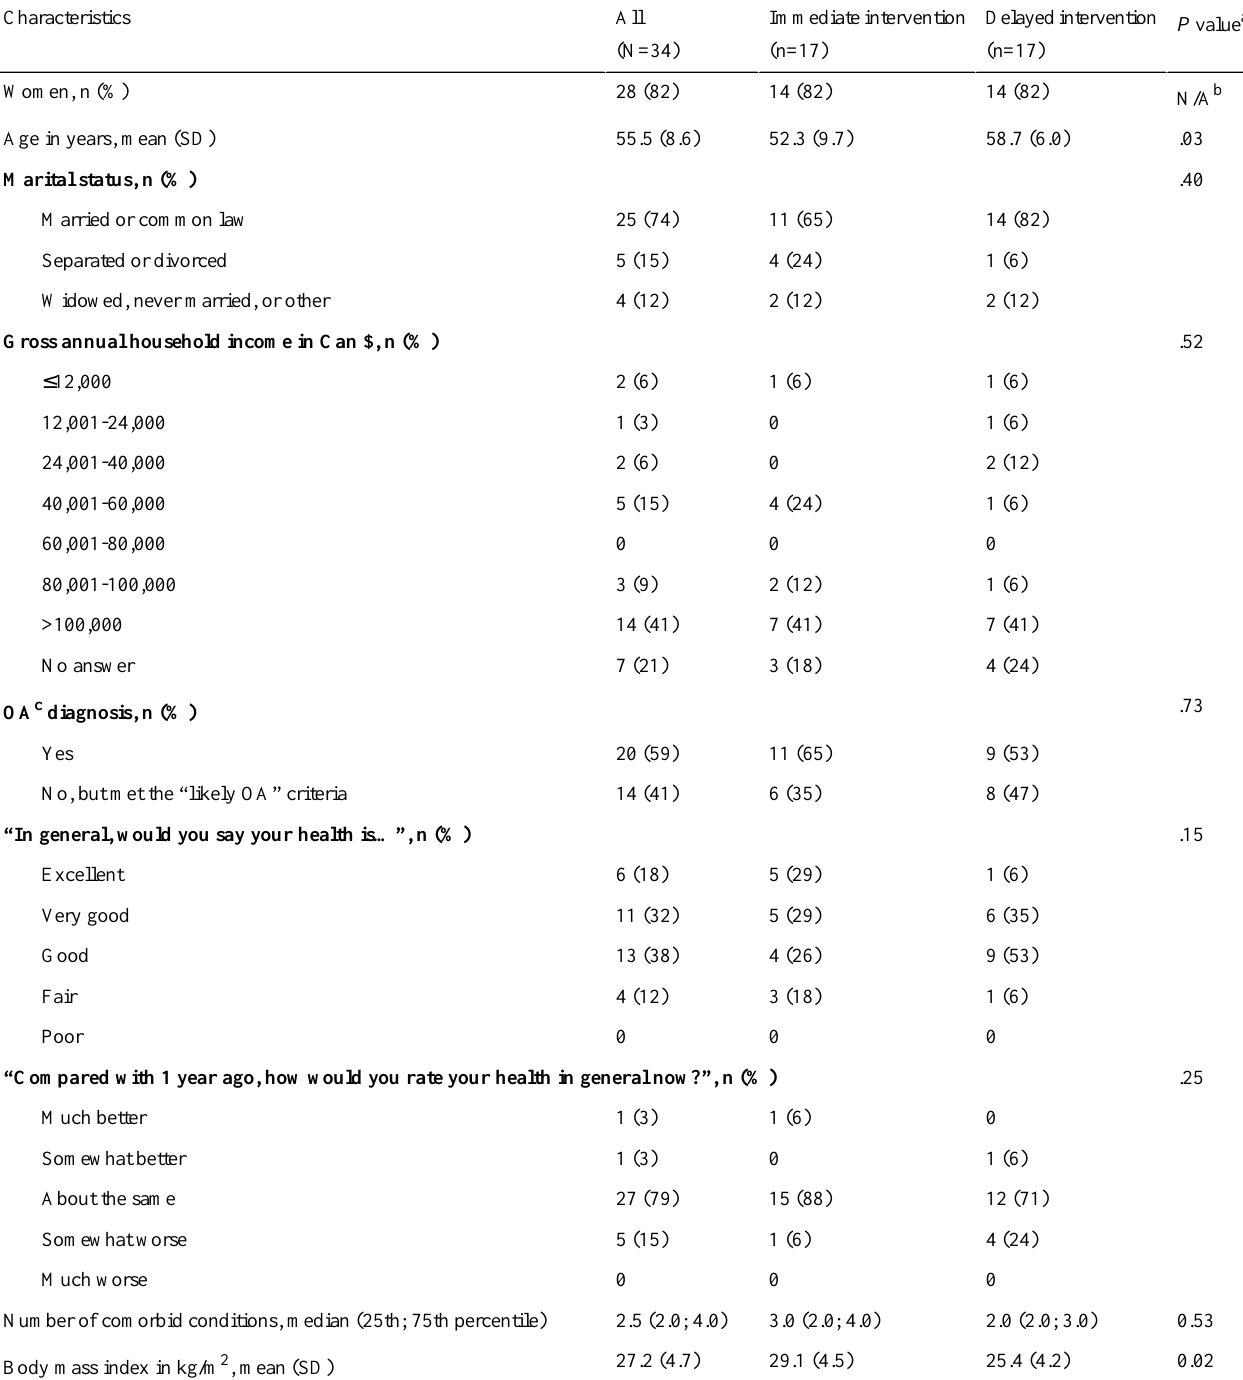
Table 1. Baseline characteristics of immediate intervention and delayed intervention